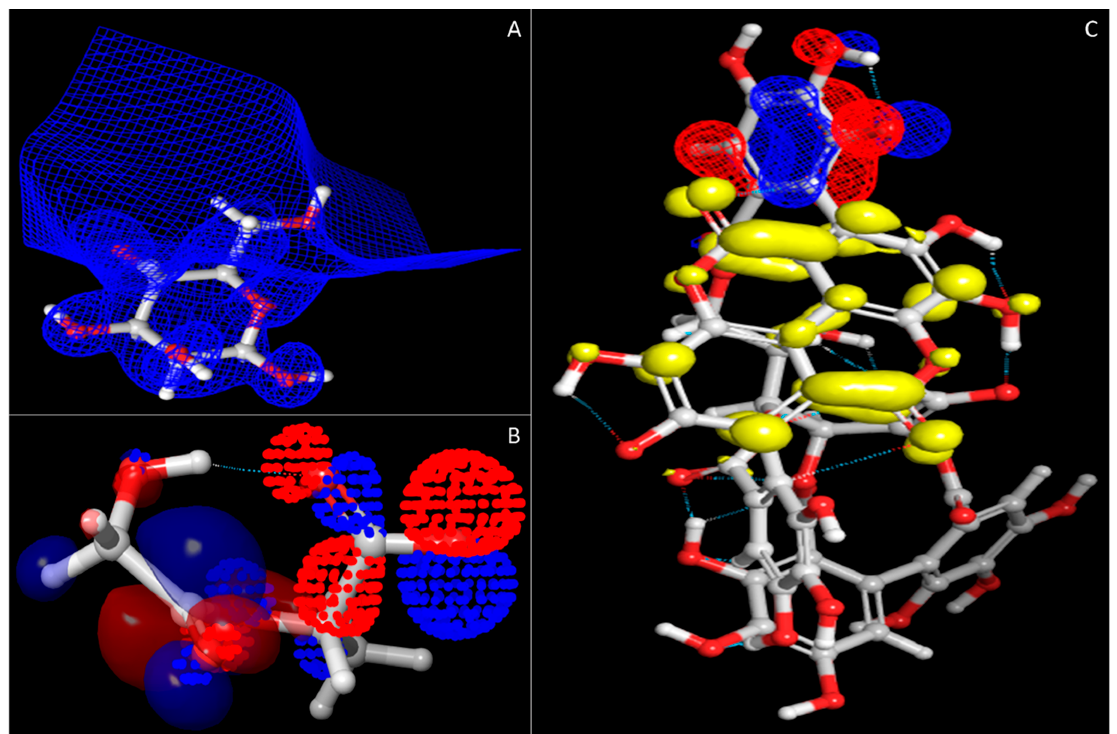
Figure 4. The HOMO and LUMO sites of all three compounds: ( A ) mannose; mesh is showing only the LUMO site as it does not have any HOMO site, ( B ) PLGA; dots are showing the HOMO site while the solid representation shows the HOMO site, ( C )punicalagin; mesh shows the HOMO site while the solid yellow site shows the LUMO site.